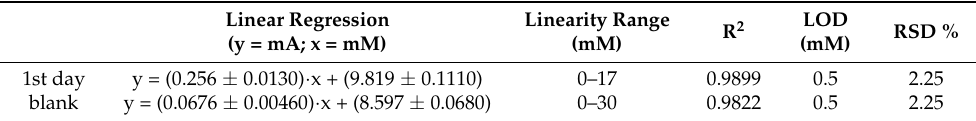
Table 1. CV method validation: main analytical data and straight-line equations of the calibration curves at the 1st day and blank curve.